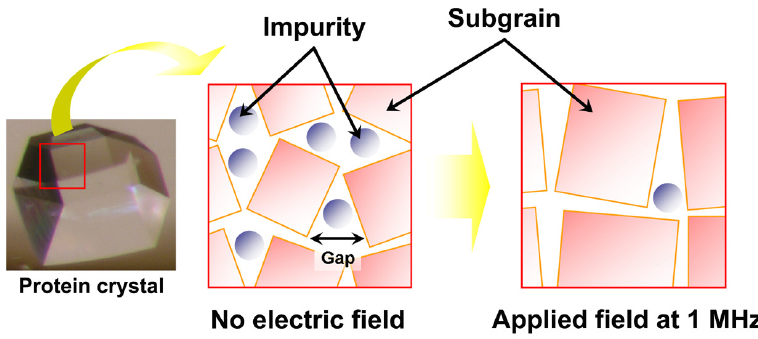
Figure 7. Model demonstrating the origin of misorientation between sub-grains in protein crystals and the effect of an external electric field on the misorientation. Reprinted with permission from reference [20]. Copyright 2014 American Chemical